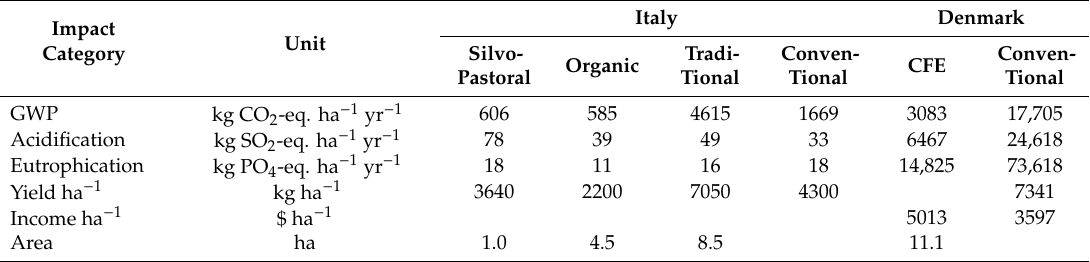
Table 5. GHG emissions ha − 1 in production systems in Italy and Denmark. CFE: combined food and energy